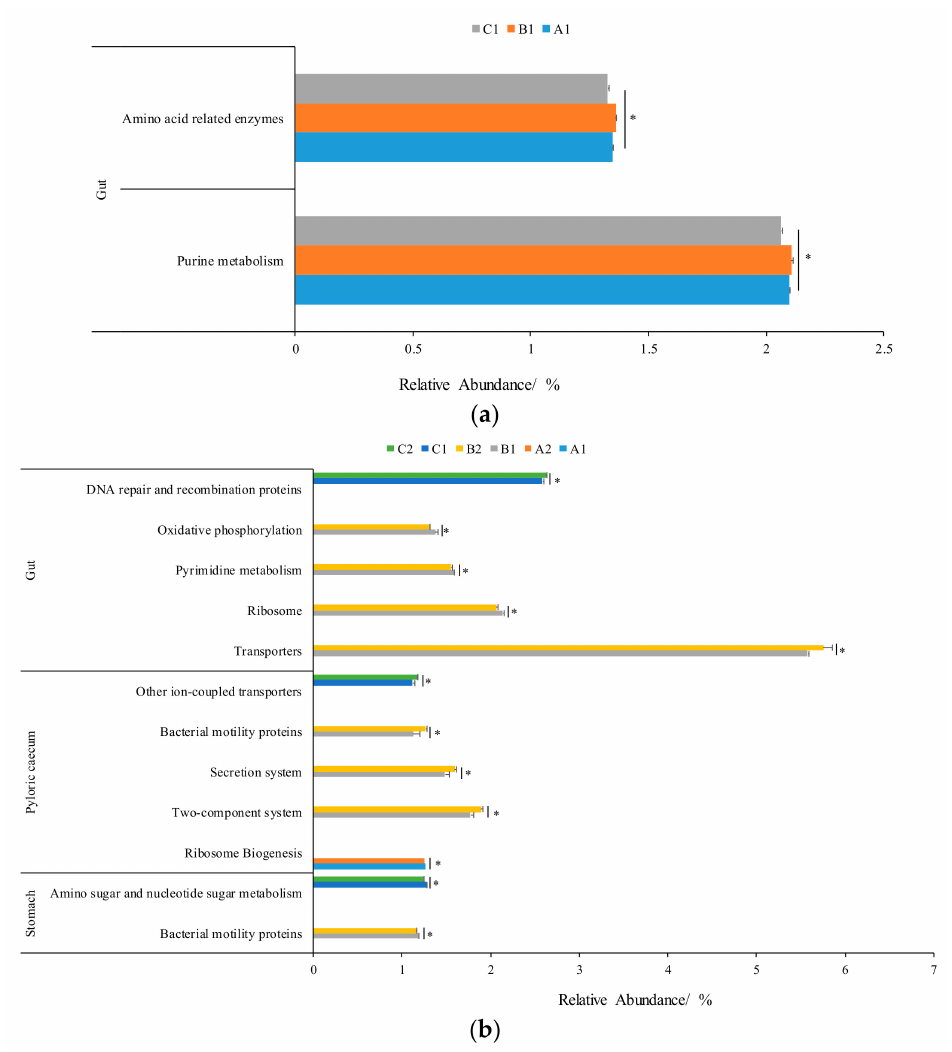
Figure 8. The dominant (top fifteen, according to the relative abundances) KEGG pathways with significant differences in the gastrointestinal microbiota. Notes: ( a ) among the three different density groups at the beginning or end of the study; ( b ) between the beginning and end of the study for each density group. A1, B1, and C1 represent the low-, medium-, and high-density groups at the beginning of the study, while A2, B2, and C2 represent the low-, medium-, and high-density groups at the end of the study. * represents the significant differences between the beginning and end of the study in each density group ( p ≤